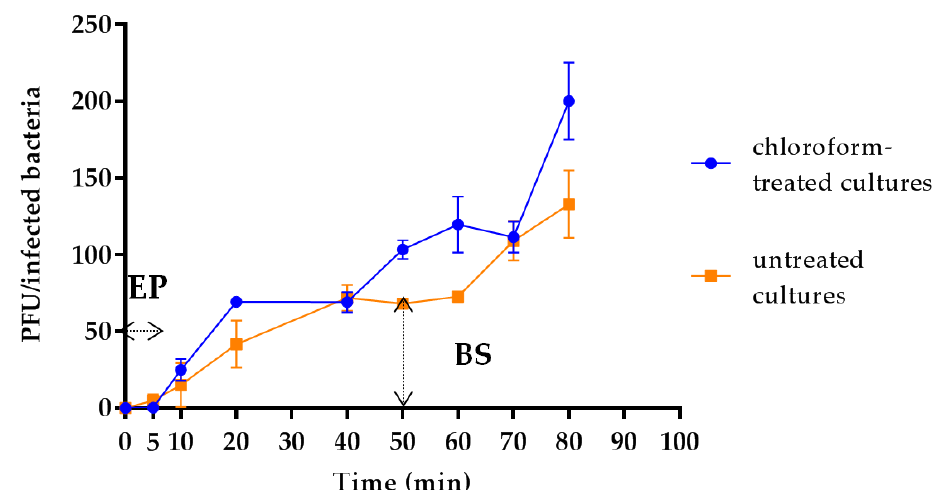
Figure 2. One-step growth curve of bacteriophage vB_Kpn_F48. The PFU per infected cell at different time points in chloroform-treated cultures (blue) and in untreated cultures (orange) are shown. EP: eclipse period; BS: burst size. Each data point is the mean from three experiments. Standard deviations are shown as vertical lines.